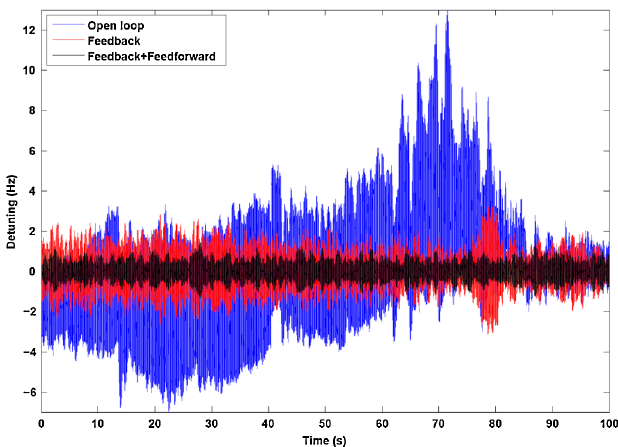
FIG. 16. (Color) Detuning compensation at 1.8 K and Q L ¼ 6 : 4 (cid:6) 10 7 in the time domain. The blue curve depicts the open loop case, the red one the feedback compensation, and the black curve the combined feedback and feedforward